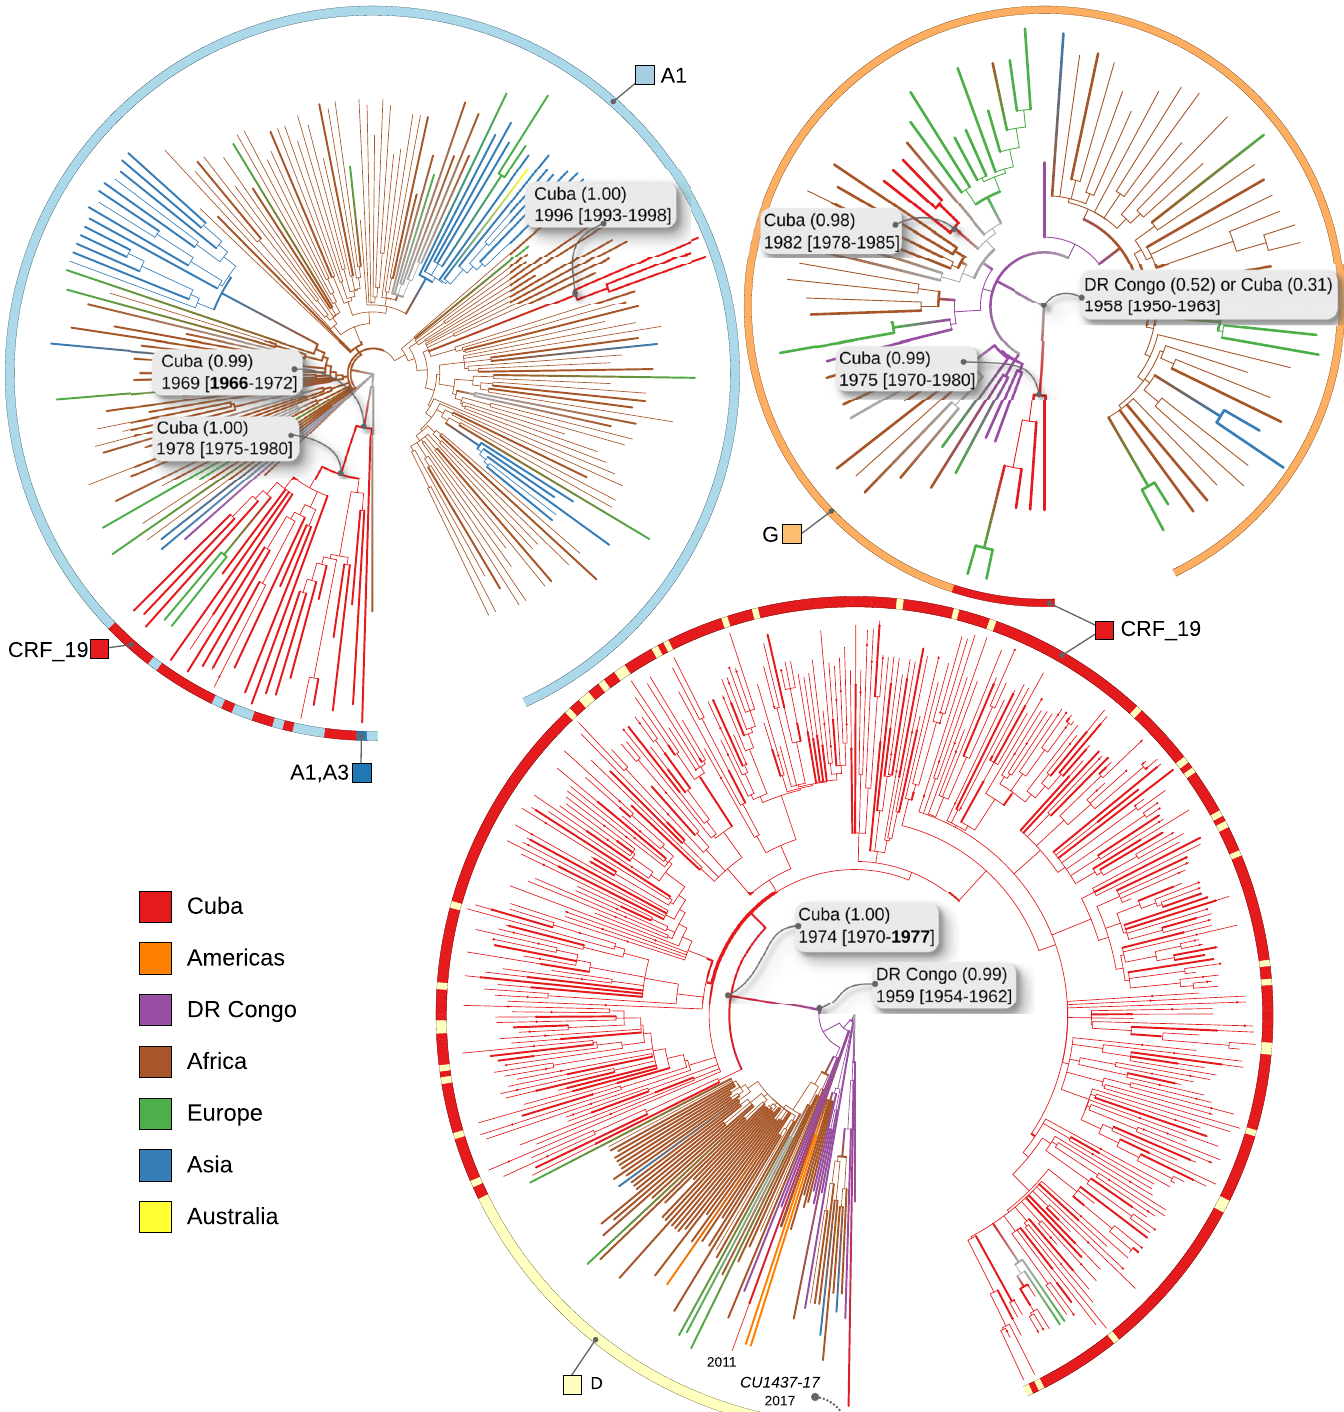
Fig 1. Time-scaled trees. reconstructed for the three data sets: A1+CRF19 (top left), G+CRF19 (top right), and D+CRF19 (bottom centre). Nodes and branches are coloured by location (ACR performed by PastML, MPPA+F81), as explained in the legend in bottom left: Cuba is coloured red, African countries are brown apart from the the DRC (violet), European countries are green, Asian countries are blue, American countries (Brazil and the USA) are orange, Australia is yellow. Colourstrips around the trees show sample subtypes: A1 (light-blue), D (yellow), G (light-orange), CRF19 (red), and A1-A3 recombinant (blue, note that this sequence was used in the A1+CRF19 data set as its part that aligns with the A1-part of CRF19 is fully A1). CRF19 sequences form a cluster for all data sets. Subtype misannotations lead to several D- and A1-annotated sequences within the corresponding CRF19 clusters, and one CRF19-annotated sequence ( CU1437–17 ) outside of the CRF19 cluster in the D +CRF19 tree. Dates (with CIs, reconstructed by LSD2) and countries (with marginal probabilities, reconstructed by PastML) of the CRF19 cluster MRCAs and their non- CRF19 (i.e. A1, D or G) parent nodes are shown. The dates of non-recombinant Cuban clusters are also shown. https://doi.org/10.1371/journal.ppat.1009786.g001 PLOS Pathogens| https://doi.org/10.1371/journal.ppat.1009786 August 9,